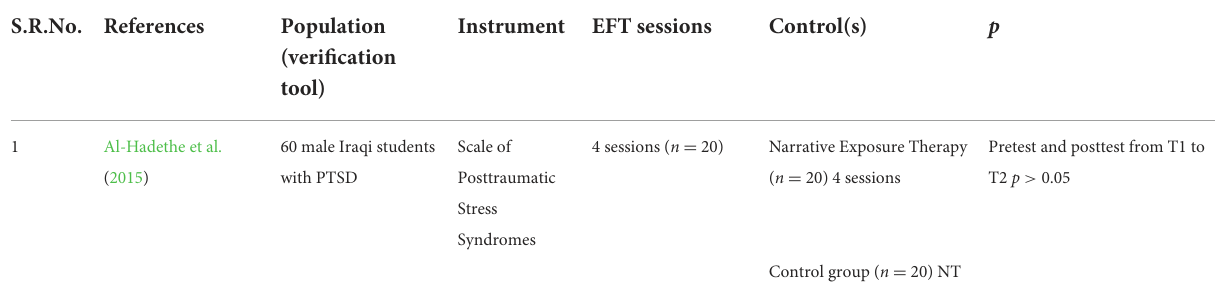
TABLE 8 PTSD RCT published since Sebastian and Nelms (2017)